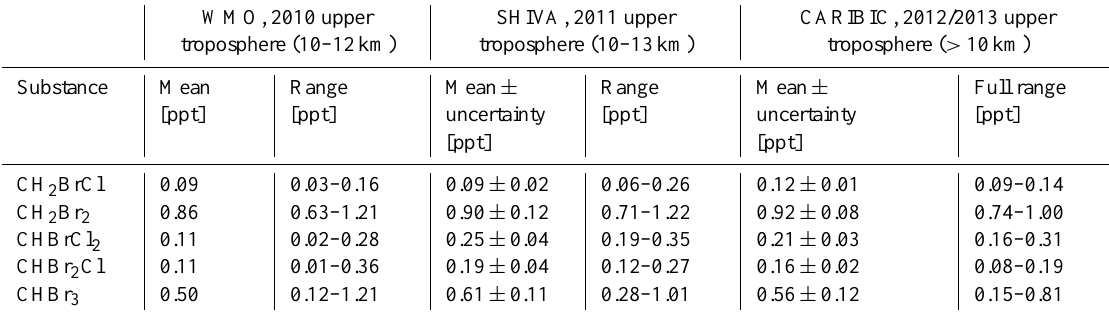
Table 7. Comparison of the upper troposphere measurements during SHIVA from GHOST with data compiled in Montzka and Reimann et al. (2011) and data published in Wisher et al. (2013) from Southeast Asia (0-15 ◦ N), derived from CARIBIC measurements. The measurement uncertainty (1 σ ) given for the SHIVA data is the sum of scale accuracy and instrumental measurement precision, excluding atmospheric variability. The range for the SHIVA data represents the 2.5 to 97.5 percentiles of the observed distribution.